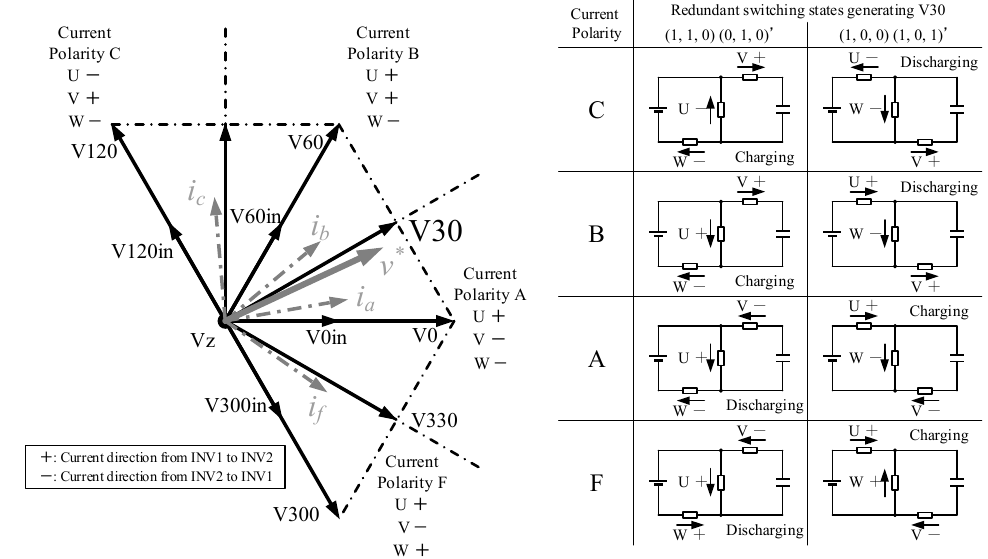
Figure 6. Impact of instantaneous motor power factor.